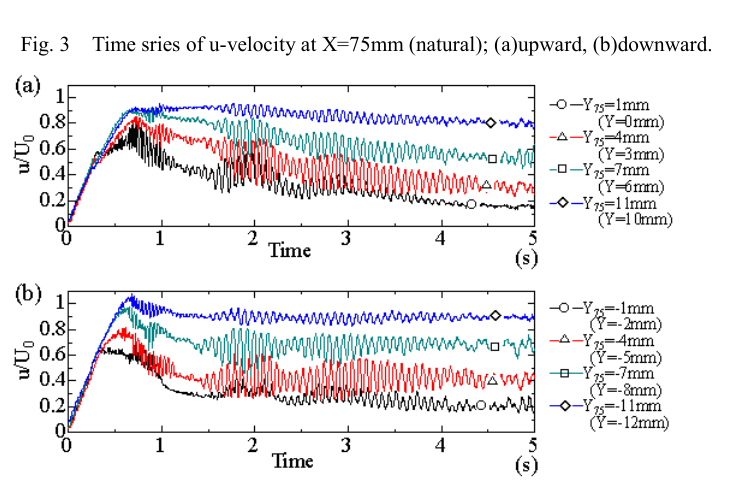
Fig. 4 Time series of u-velocity at X=75mm (with 14Hz forcing); (a)upward, (b) downward. respectively. In these figures, figures (a) and (b) indicate the velocity fluctuations of the upward and downward locations, respectively. The streamwise velocities shown in these figures indicate that the airfoil starts to run at a constant speed after an accelerated period of about 0.6 seconds. Furthermore, the velocities near the center lines first show a departure from the acceleration straight lines during the accelerated period, and then decrease to the steady state. After the accelerated period, the velocities of other locations also decrease to the steady state of the wake. This fact means that the wake width and deficit grow gradually after the accelerated period. Figures (a) and (b) show that they develop asymmetrically about the wake center. During the velocity decrease period, the velocity fluctuations appear with relatively higher frequency. These fluctuations correspond to a fine structure of